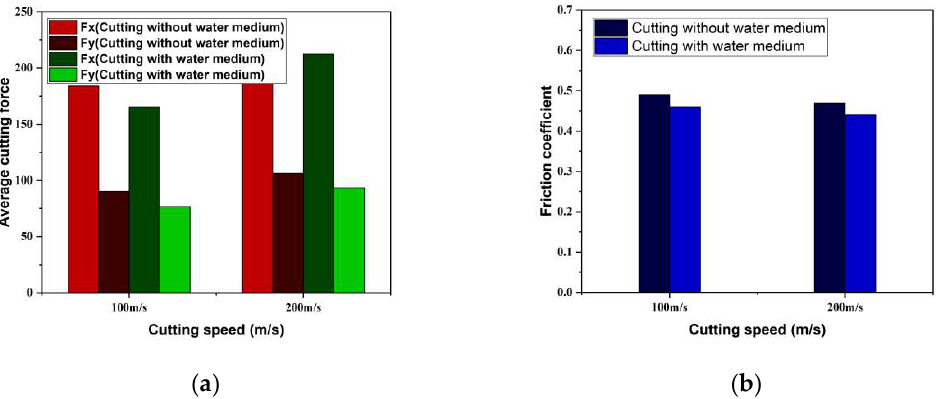
Figure 12. Average cutting force and friction coefficient at different cutting speeds (( a ) average cutting force at different cutting speeds ( b ) friction coefficient at different cutting speeds).